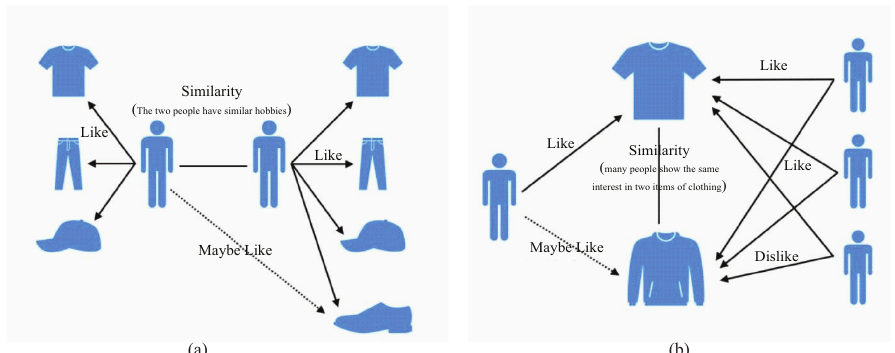
Figure 1. The main architecture of CF model.